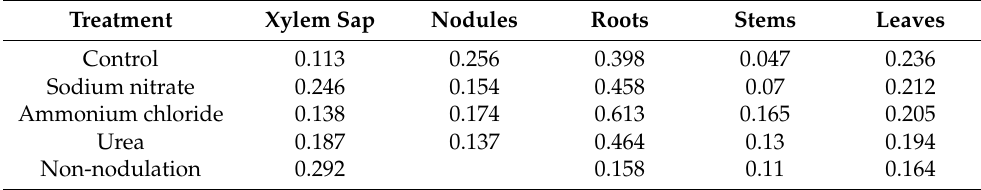
Table 1. Ratios of urea-N/ureide-N in the xylem sap and in each part of the soybean plants.